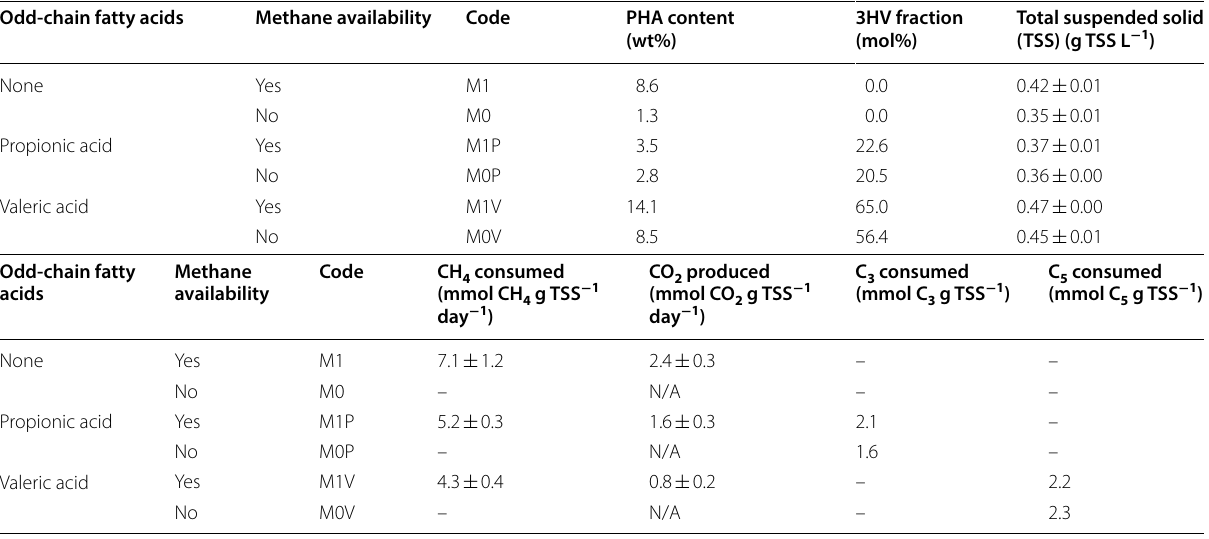
Table 1 PHA content and composition produced by the Methylosinus -dominated culture